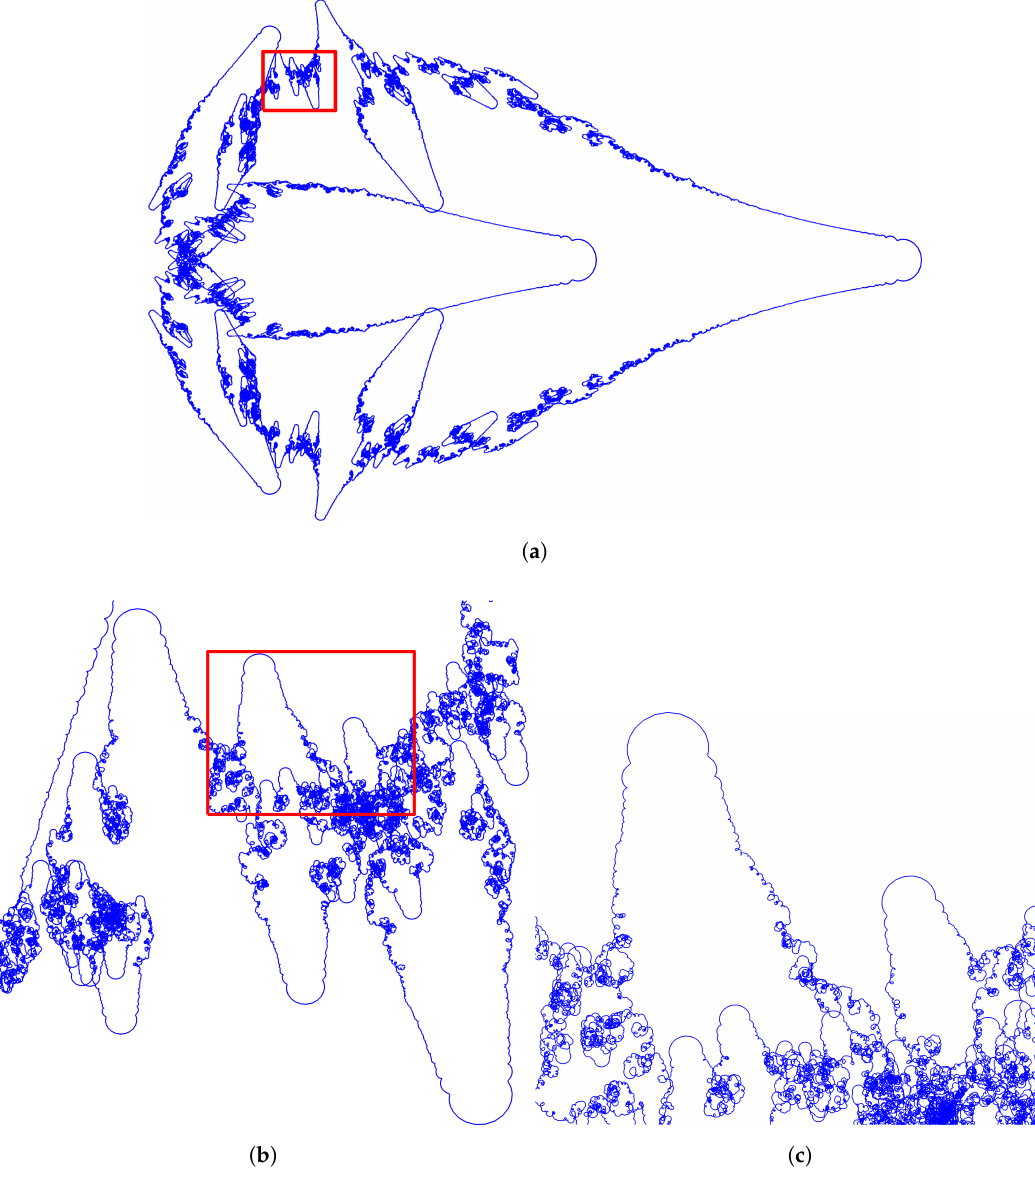
Figure 5. Prime fractal curve F c for n = 10 6 and 10 7 evaluation points t k ∈ ( − π , π ] . Boxes of successive zooms are marked red. ( a ) Full fractal; ( b ) Zoom level 1; ( c ) Zoom level 2. Figure 6 depicts the number of nonempty intersection boxes N m versus the grid width ε m for m ∈ { 0, . . . , 20 } using logarithmic scales for both axes. The fractal dimension estimate derived by the slope of the line of best fit of these 21 points amounts to d ≈